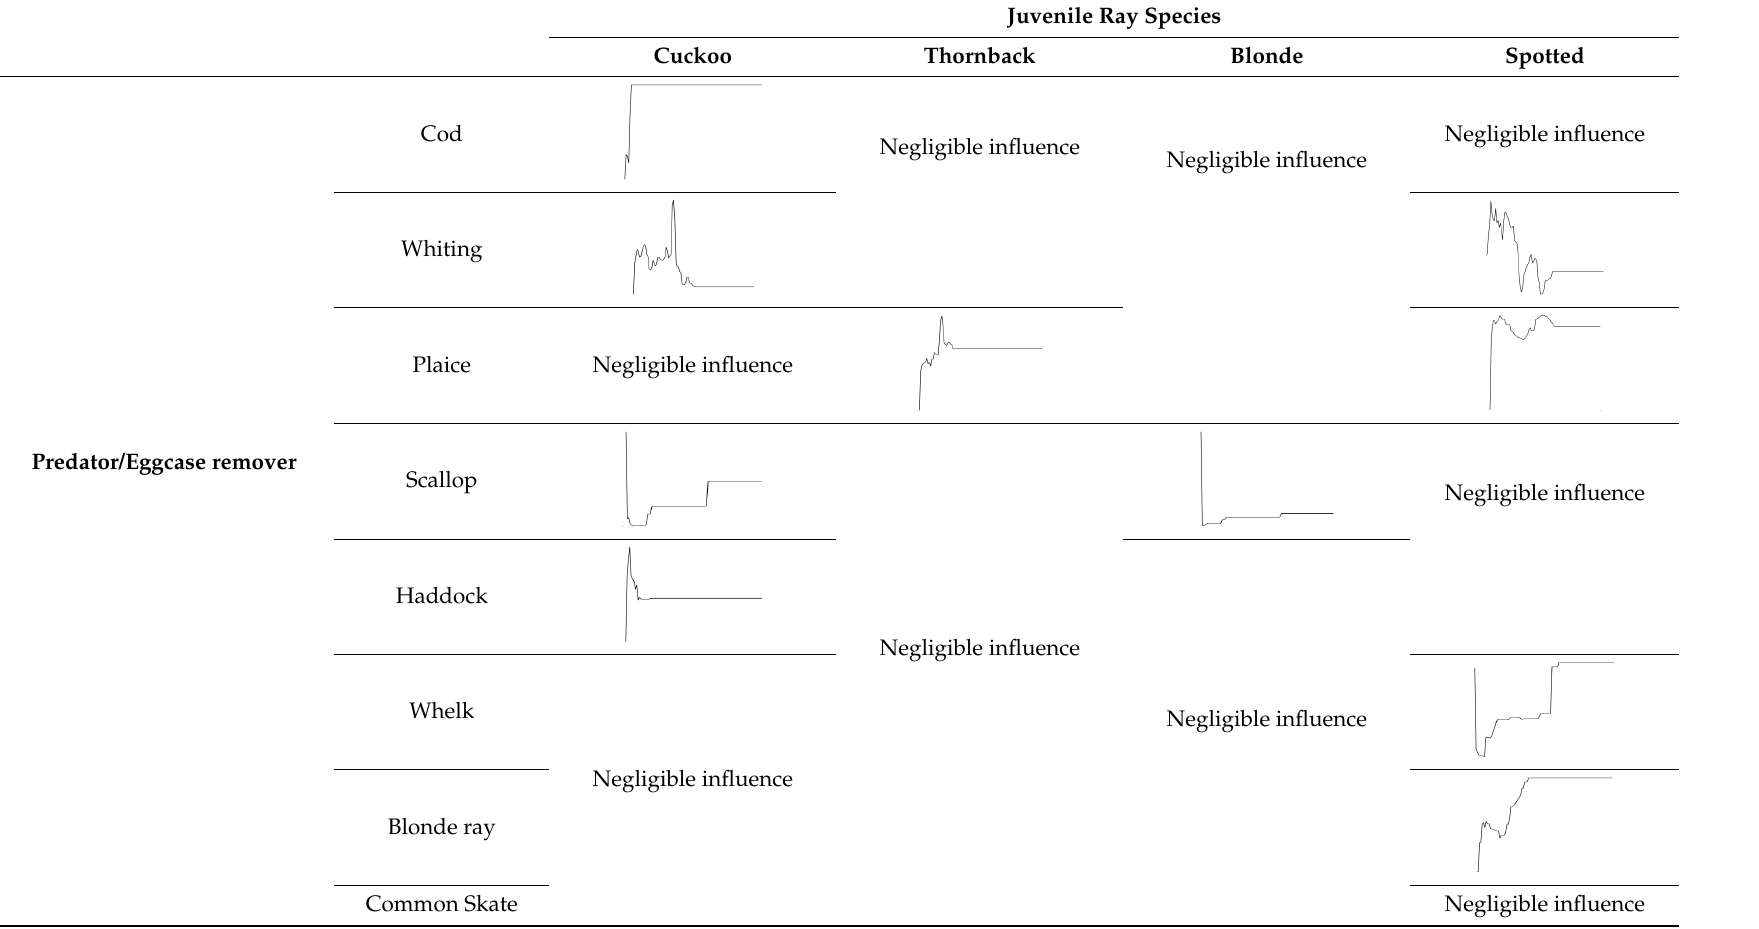
Table 1. Influence and relationship of eggcase removers and predators upon juvenile ray CPUE, represented by partial dependence plots produced by the model. The horizontal axes represent rising levels of the predictor variable, the vertical axes represent rising levels of the response variable, i.e., ray CPUE. Bar plots of variable influence, and full partial dependence plots for juvenile and mature female CPUE are available in Figure S2a–i.